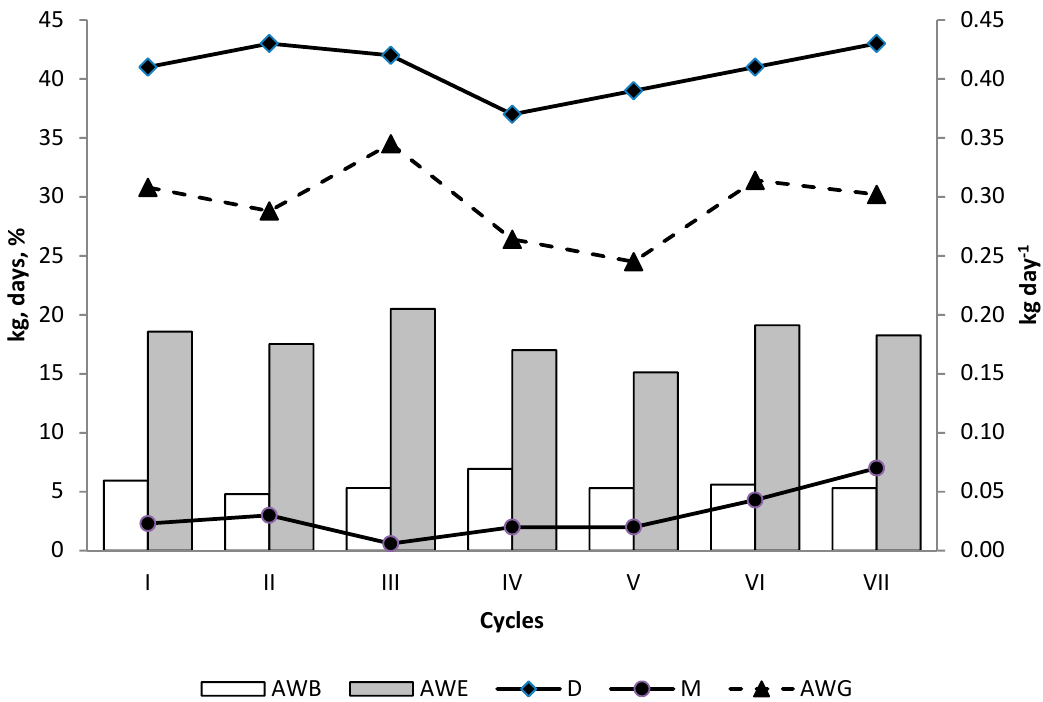
Figure 2. Production variables for each cycle. AWB: Average weight at the beginning of the cycle (kg), AWE: Average weight at the end of the cycle (kg), D: Duration (days), M: Mortality (%), AWG: Daily average weight (kg day − 1 ).